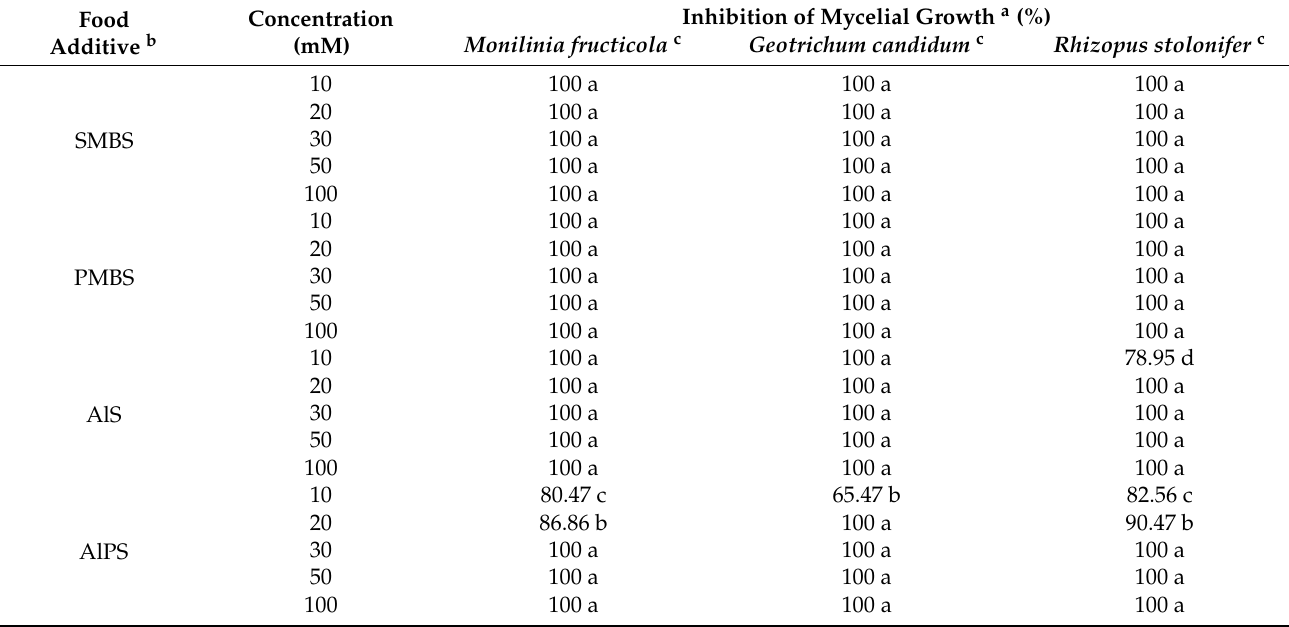
Table 1. Inhibition of mycelial growth (%) of stone fruit postharvest pathogens on PDA Petri dishes amended with sulfur-containing food additives at several concentrations and incubated at 25 ◦